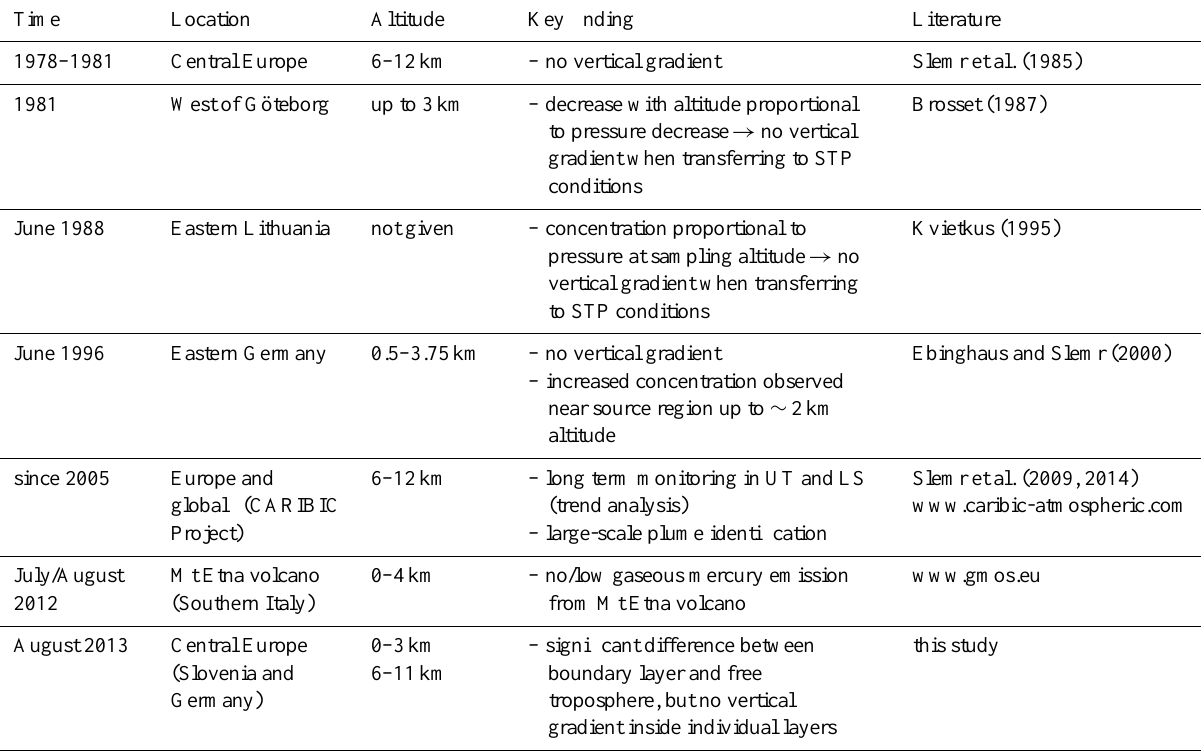
Table 1. Summary of all known European airborne atmospheric mercury measurements until December 2014.